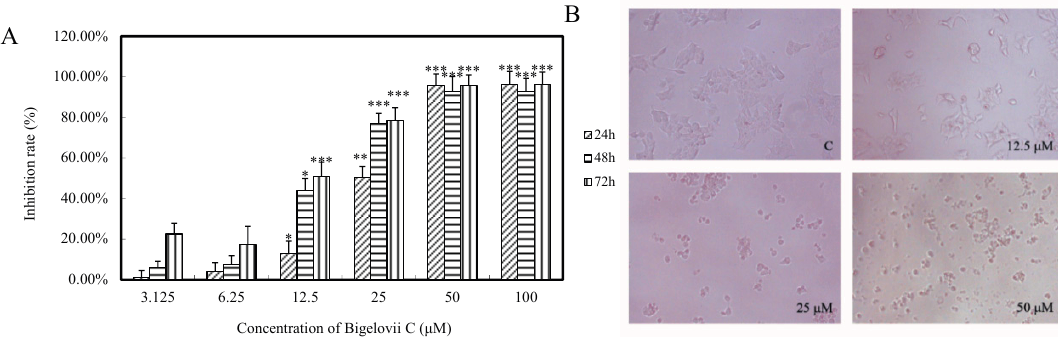
Figure 3. Bigelovii C had potent cytotoxic activity on MCF-7 cells. ( A ) Cells were treated with bigelovii C for 24 h, 48 h and 72 h. Cytotoxicity was evaluated by the MTT assay. * p < 0.05, ** p < 0.01 and *** p < 0.001, compared with the control group. ( B ) Morphological observation of MCF-7 cells treated with 12.5 μ M, 25 μ M and 50 μ M bigelovii C for 24 h under optical microscopic observation